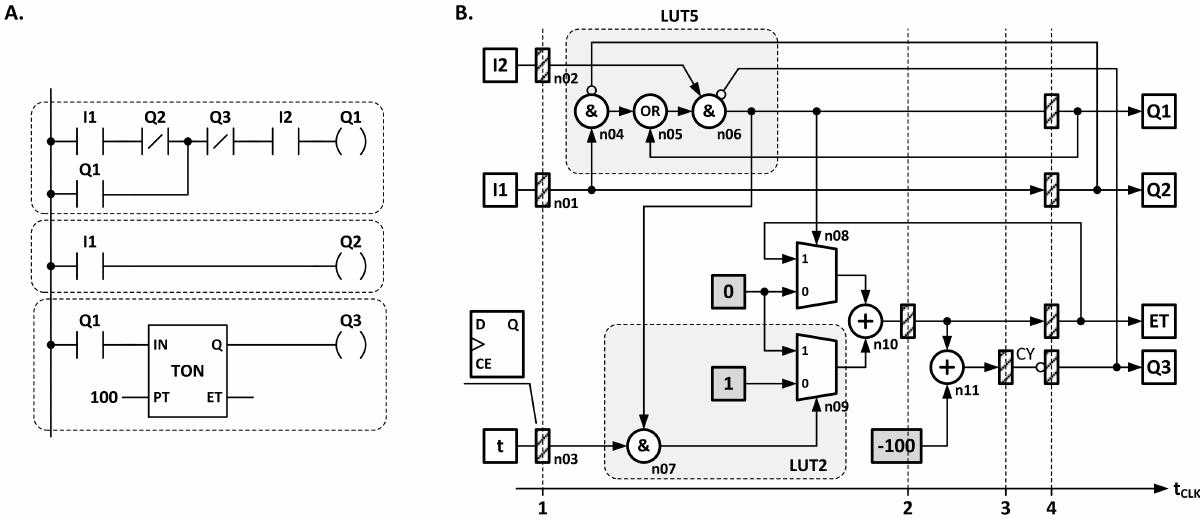
Figure 14. An exemplary LD program ( A ) and its respective data flow graph scheduled and prepared for LUT mapping ( B